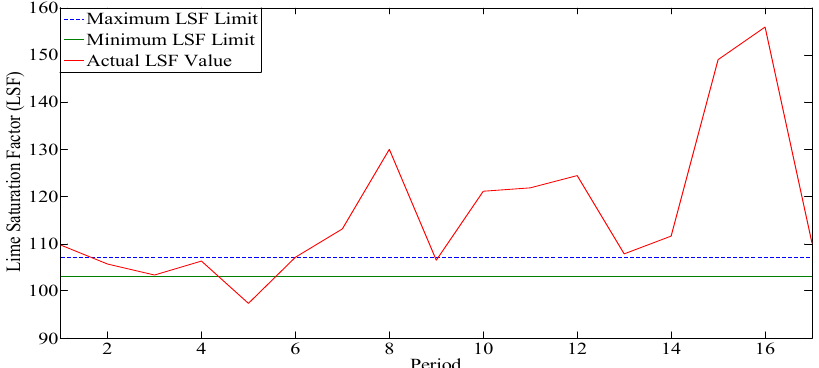
Figure 11. Model 2 LSF value for 17 periods with LSF bound.